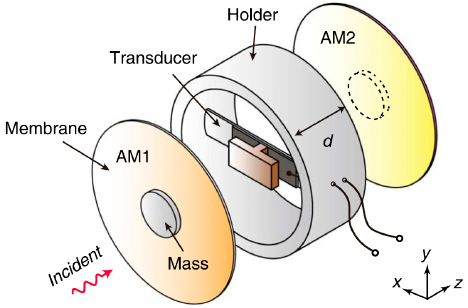
Figure 38. Scheme of an LAM-based AEH system [208].